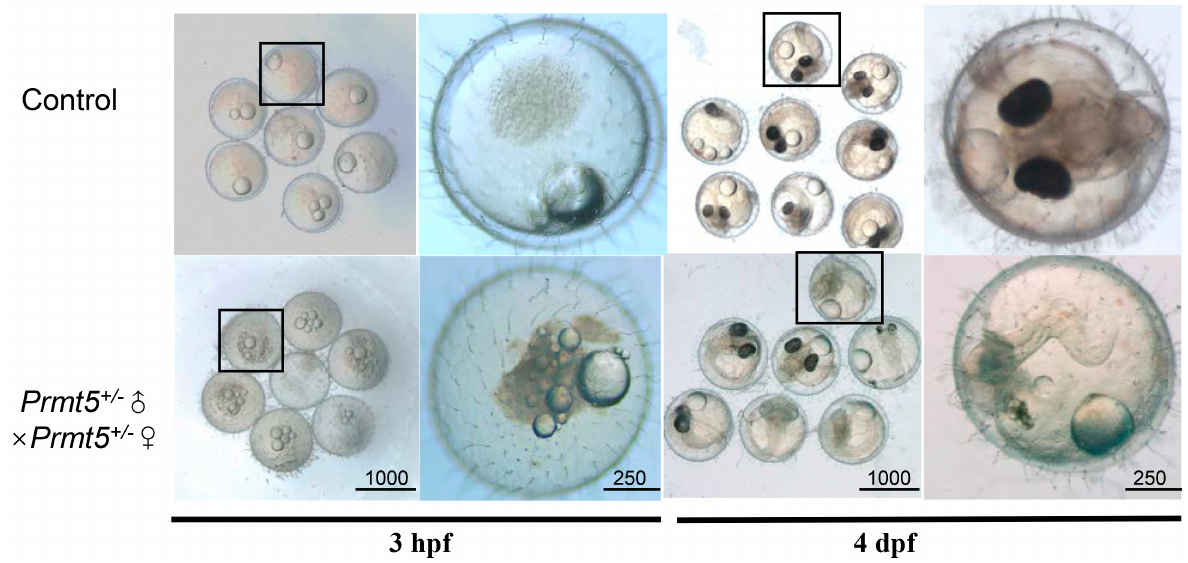
Figure 3. The embryos of the control and the offspring of the heterozygous fish at different stages (3 hpf and 4 dpf). The framed embryos are shown in enlarged pictures. The mutant offspring could have died in 3 hpf, developed slowly with minor or pigment-less eyes, abnormal body axis, and/or headless in 4 dpf. Scale bar, 1000 or 250 μ m.